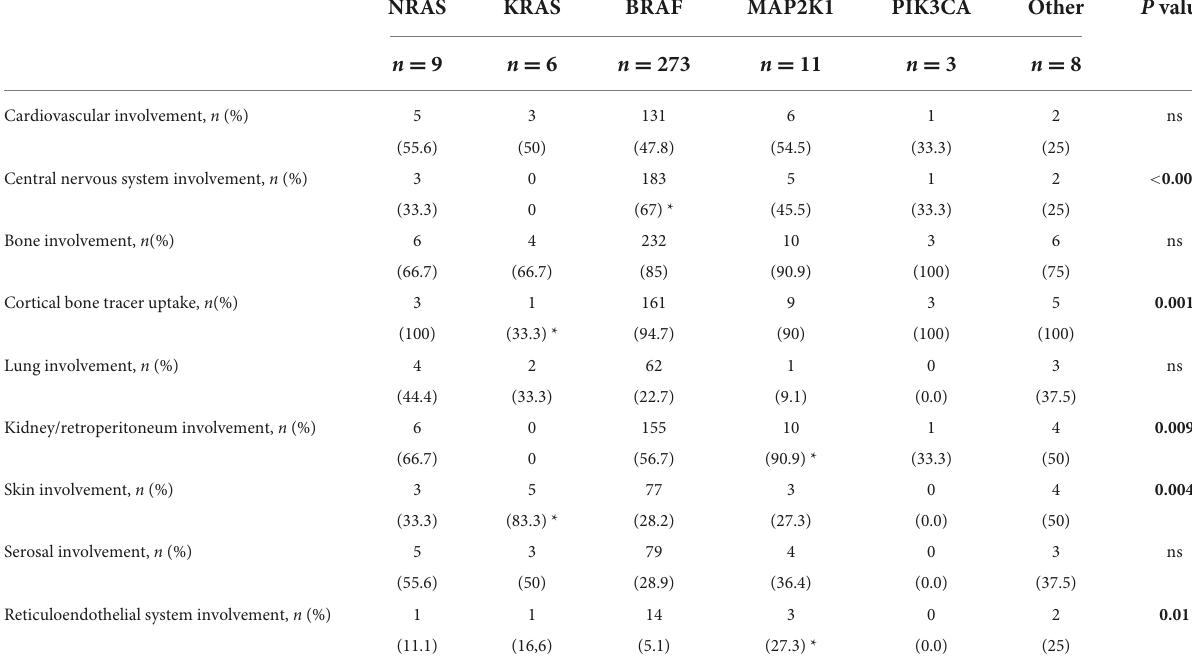
TABLE 2 Clinical characteristics of Erdheim–Chester patients according to different